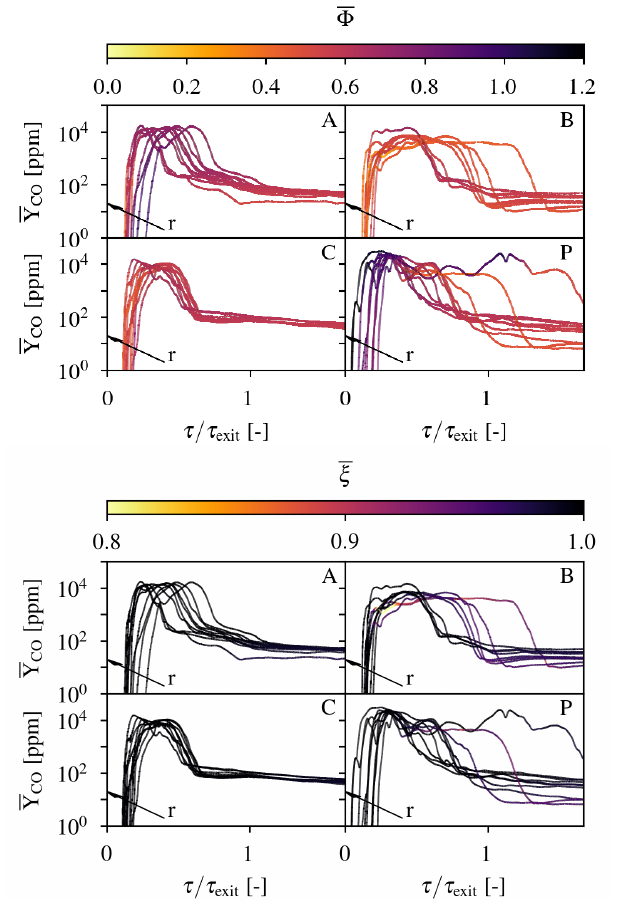
Figure A3. Lagrangian particle history of carbon monoxide in dependency of the equivalence ratio Φ ( top ) and the primary air ratio ξ from the different stages for case 1C. Time is normalized by the combustor exit time τ exit . The temporal shift is related to the injection radius r